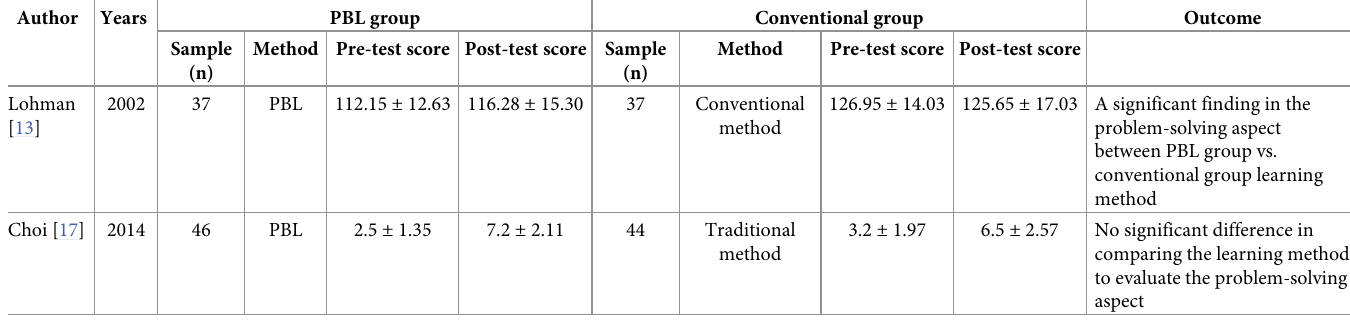
Table 3. Problem-solving score analysis of both